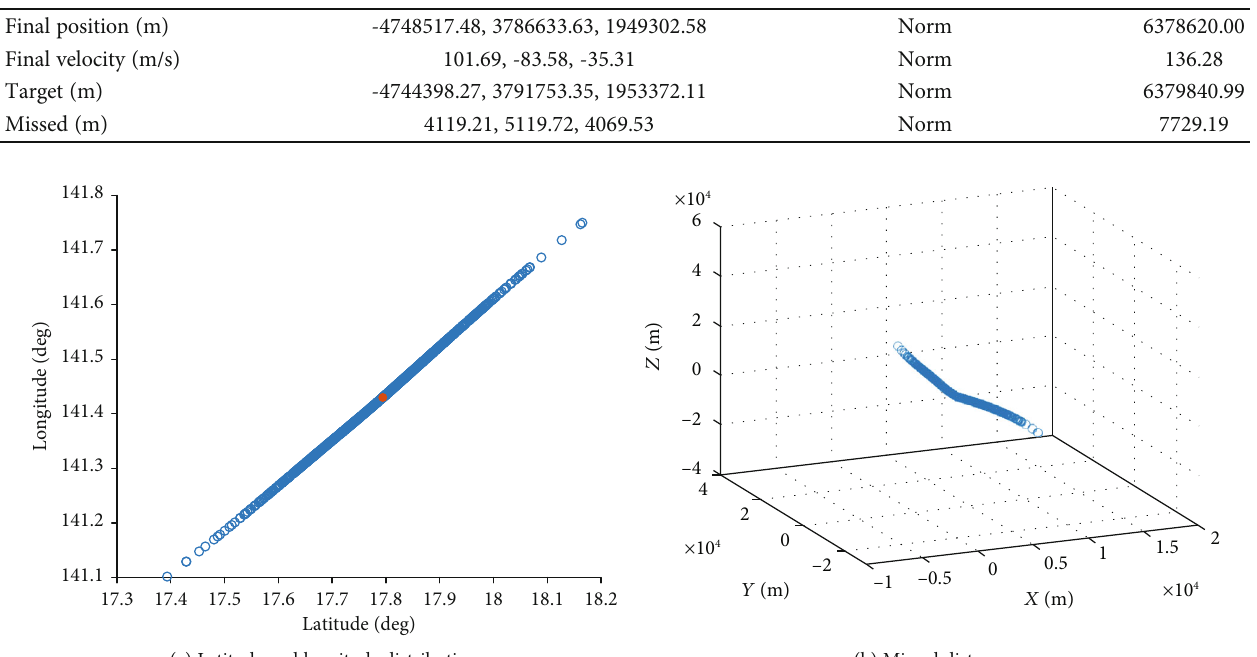
Table 5: Nonlinear integration using 10-layer NN in the Earth model.